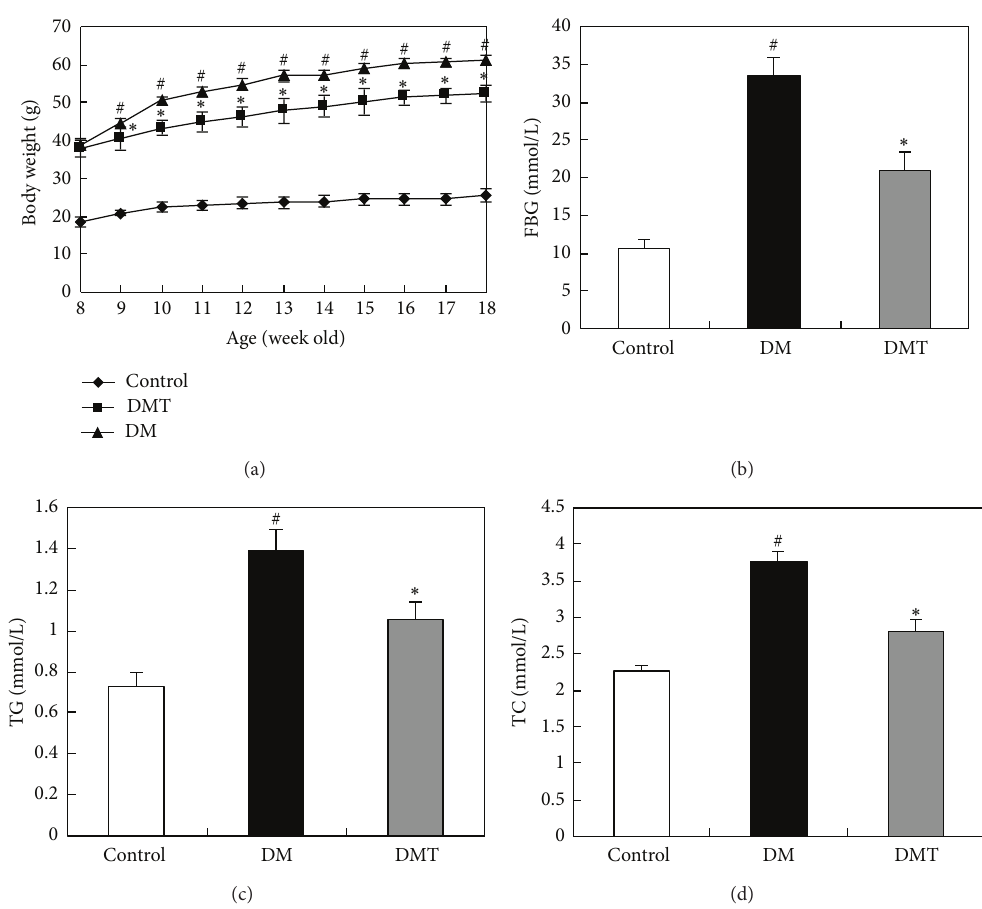
Figure 1: General metabolic parameters. (a) Body weight change of mice in the control, DM, and DMT groups. ((b), (c), (d)) Serum FBG, TG, and TC were measured after 10 weeks. # 𝑃 < 0.05 and indicates a significant difference between the control and DM group; ∗ 𝑃 < 0.05 and indicates a significant difference between the DMT and DM group ( 𝑛 = 8 ). DM: vehicle-treated diabetic group; DMT: diabetic group treated with 20 mg/kg phlorizin; FBG: fasting blood glucose; TG: triglycerides; TC: total cholesterol.